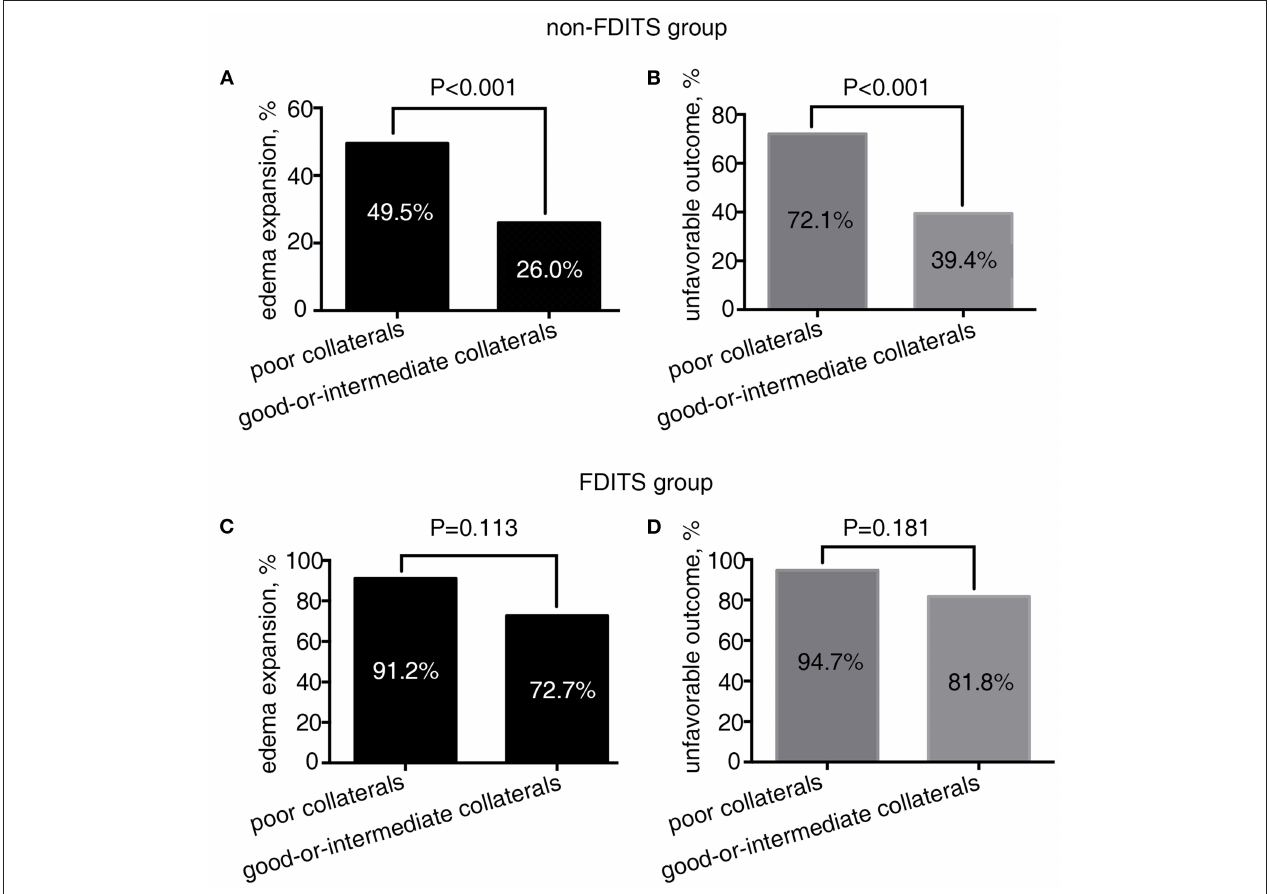
FIGURE 2 | The relationship between collateral status and outcome in the filling defect of ipsilateral transverse sinus (FDITS) and non-FDITS groups. The poor collaterals subgroup was more likely to undergo edema expansion (A) and an unfavorable outcome (B) than those with good-or-intermediate collaterals in patients with non-FDITS. While in the FDITS group, no significant difference was found in the rate of edema expansion (C) or an unfavorable outcome (D) between patients with poor and good-or-intermediate collaterals. Baseline relative cerebral blood flow (rCBF) < 30% was used for calculating the ischemic core volume (15). At 24 h, Diffusion Weighted Imaging (DWI) or NCCT was used to calculate the final infarct volume (